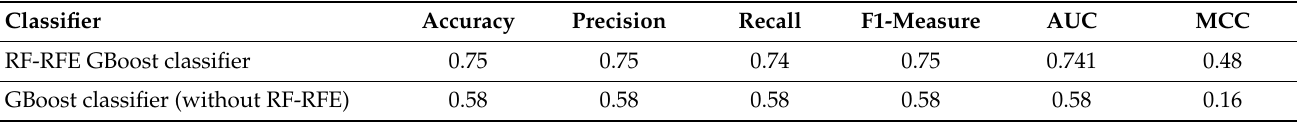
Table 4. Performance GBoost classifier on the dataset with and without